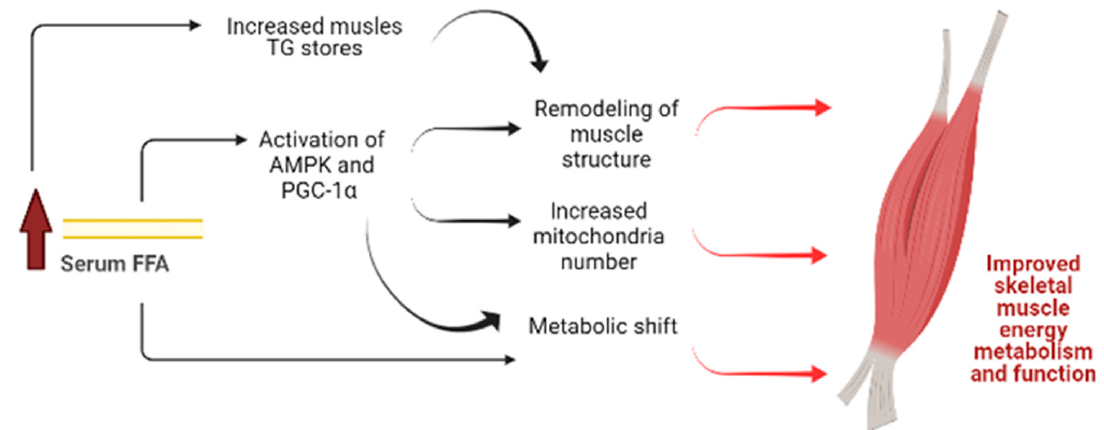
Figure 10. A model depicting the mechanism by which increased serum free fatty acids (FFA) concentration may lead to improvement of skeletal muscle metabolism and function in ApoE/LDLR -/- mice. Increased FFA levels led to 1. Elevation of skeletal muscle triglycerides stores and 2. Activation of AMPK as well as PGC- 1 α signaling pathways. Those factors may induce remodeling of muscle structure. Enhanced AMPK phosphorylation and PGC- 1 α levels activated the mitochondrial biogenesis that resulted in increased mitochondria number. Heightened FFA levels accompanied with AMPK activation led to metabolic shift resulting in increased skeletal muscle FFA oxidation. These alterations may contribute to improved skeletal muscle energy metabolism and thus enhanced grip strength and physical performance of ApoE/LDLR -/- mice. The hypothesis was supported by the demonstration that inhibition of FFA oxidation via Ranolazine resulted in depletion of skeletal muscle total nucleotides pool as well as the abolishment of improved mice exercise capacity. Created with Bioreder.com at 2 November 2021.